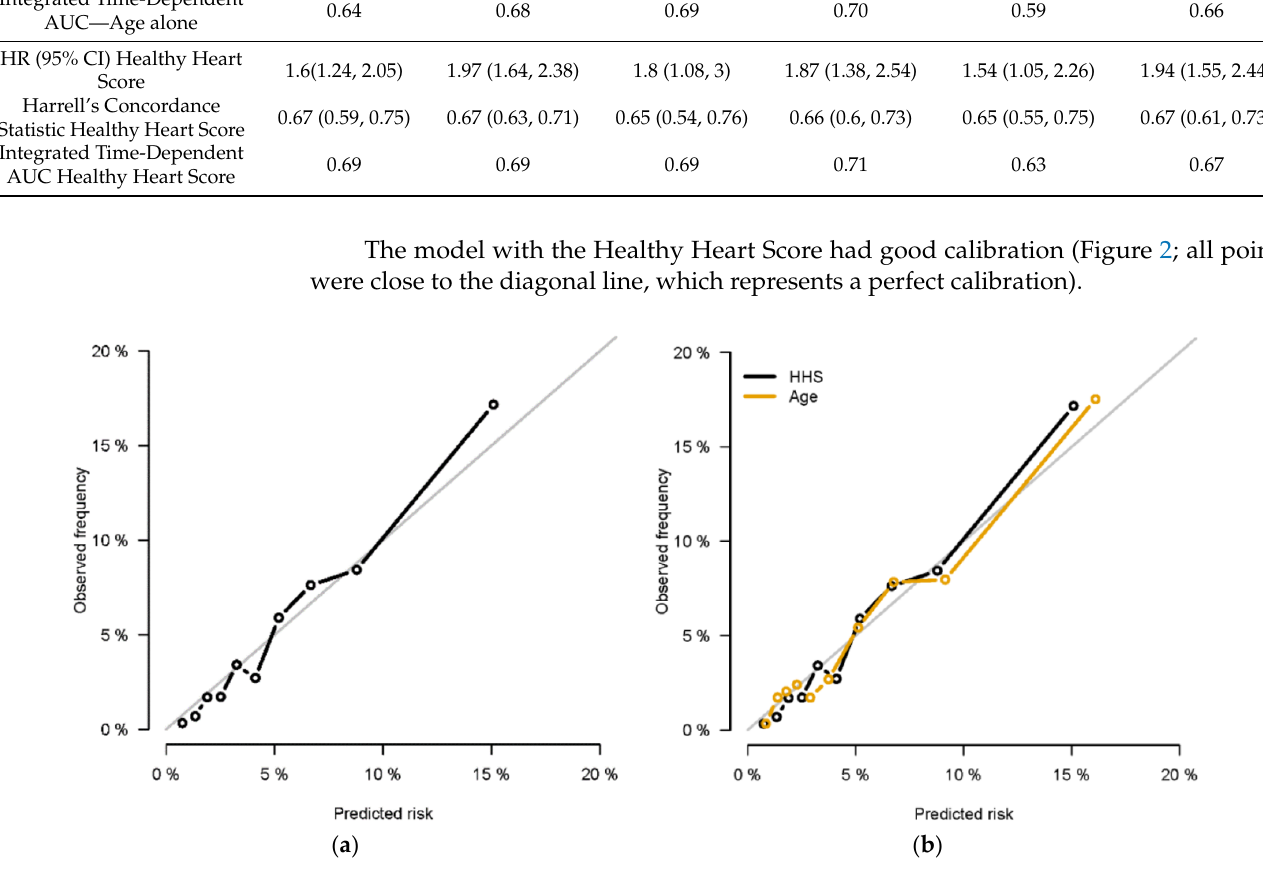
Figure 2. ( a ) Calibration Plot of Observed to Estimated risk of CVD for model with the Healthy Heart Score (HHS). ( b ) Calibration Plot of Observed to Estimated risk of CVD comparing HHS model vs. age alone model (plotting the average predicted risk within deciles of predicted risk observed risk in that decile). The diagonal line represents a perfect calibration.